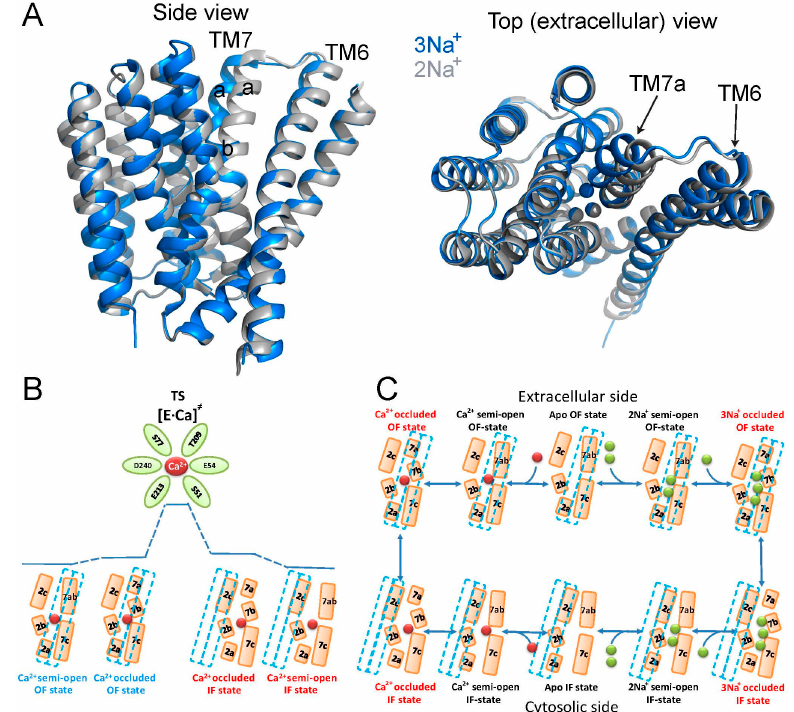
Figure 4. Ligand-induced alternating access in NCX_Mj. ( A ) the crystal structures of NCX_Mj bound to 3Na + ions ( blue , PDB 5HXE) and 2Na + ions ( gray , PDB 5HWX) are superimposed and viewed from the membrane plane ( left ) and from the extracellular side ( right ). Note the change in distance between TM6 and TM7ab induced by ligand binding; ( B ) the proposed “one-transition/two-occluded state” model for Ca 2+ translocation from the extracellular to the cytosolic side, whereas the Ca 2+ -occluded state is more stable in the extracellular orientation (the outward-facing state) as compared with the cytosolic one (the inward-facing state). [E·Ca] ≠ is the Ca 2+ -bound transition state; and ( C ) the Na + /Ca 2+ exchange cycle is described as a separate translocation of 1Ca 2+ or 3Na + , where the extracellular occlusion of either ion is more stable than the cytosolic one. Green and red spheres represent Na + and Ca 2+ ions, respectively. The gating bundle (TM1/TM6) is represented as a dashed line. In the frame of the “one-transition/two-occluded state” model, the movement of the TM1/TM6 bundle is driven by the transition state and not by the occlusion or semi-open states.